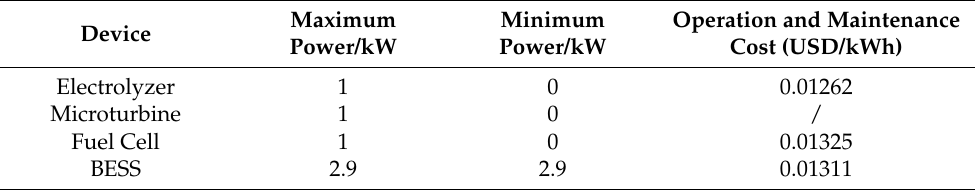
Table 2. Parameters of devices in microgrid.